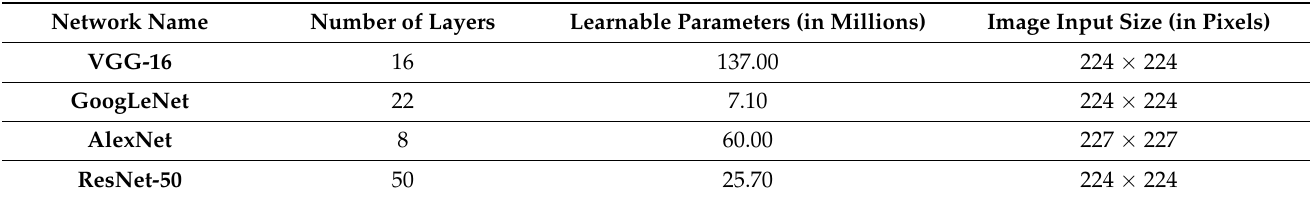
Table 2. Characteristics of networks (pretrained) that implement transfer